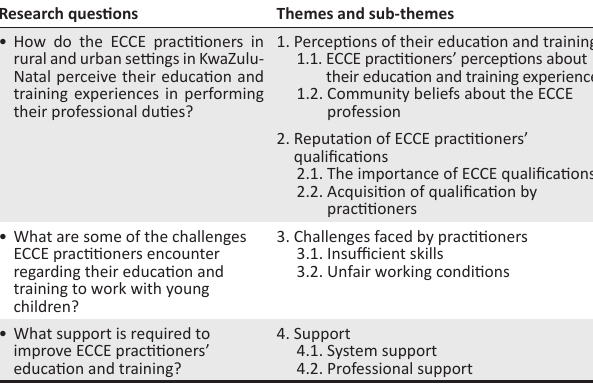
TABLE 2: Themes related to each research